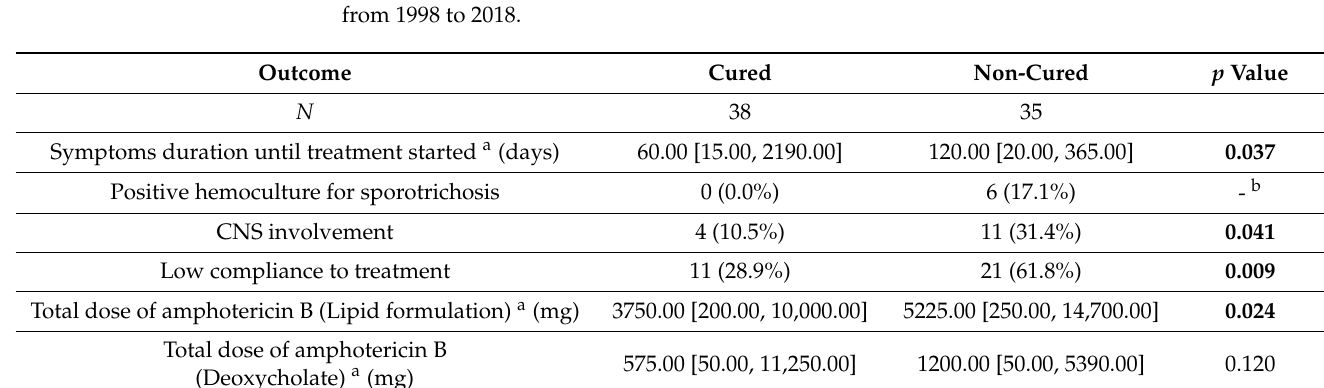
Table 3. Comparative between cured and non-cured patients with sporotrichosis treated with Amphotericin B at the Evandro Chagas National Institute of Infectious Diseases (INI/FIOCRUZ) from 1998 to